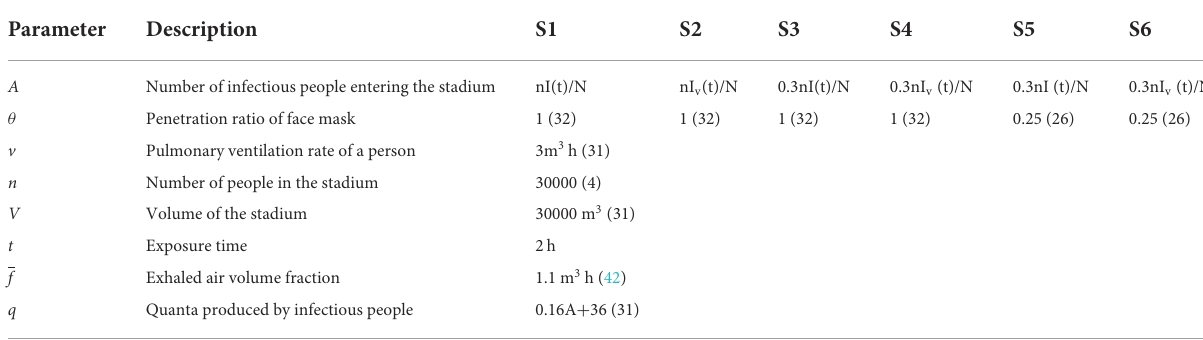
TABLE 2 Parameters in the Wells–Riley model.